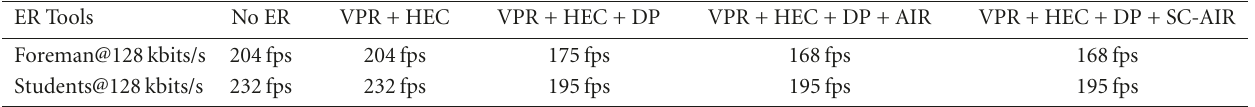
Table 4: Complexity analysis of the transcoder’s ER